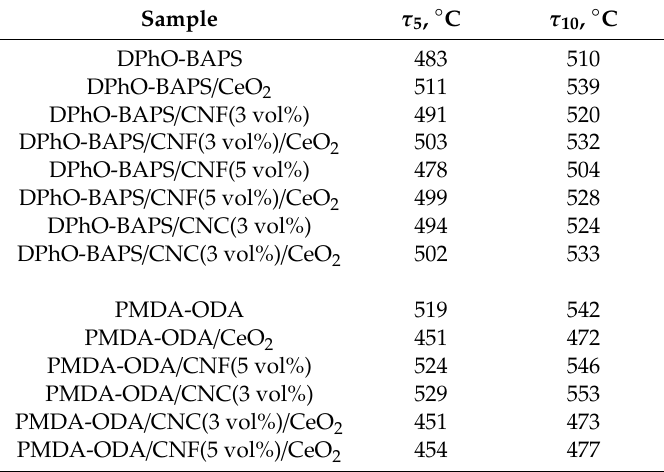
Table 1. Thermal stability indices of polyimides (PIs) and PI-based nanocomposites. Sample